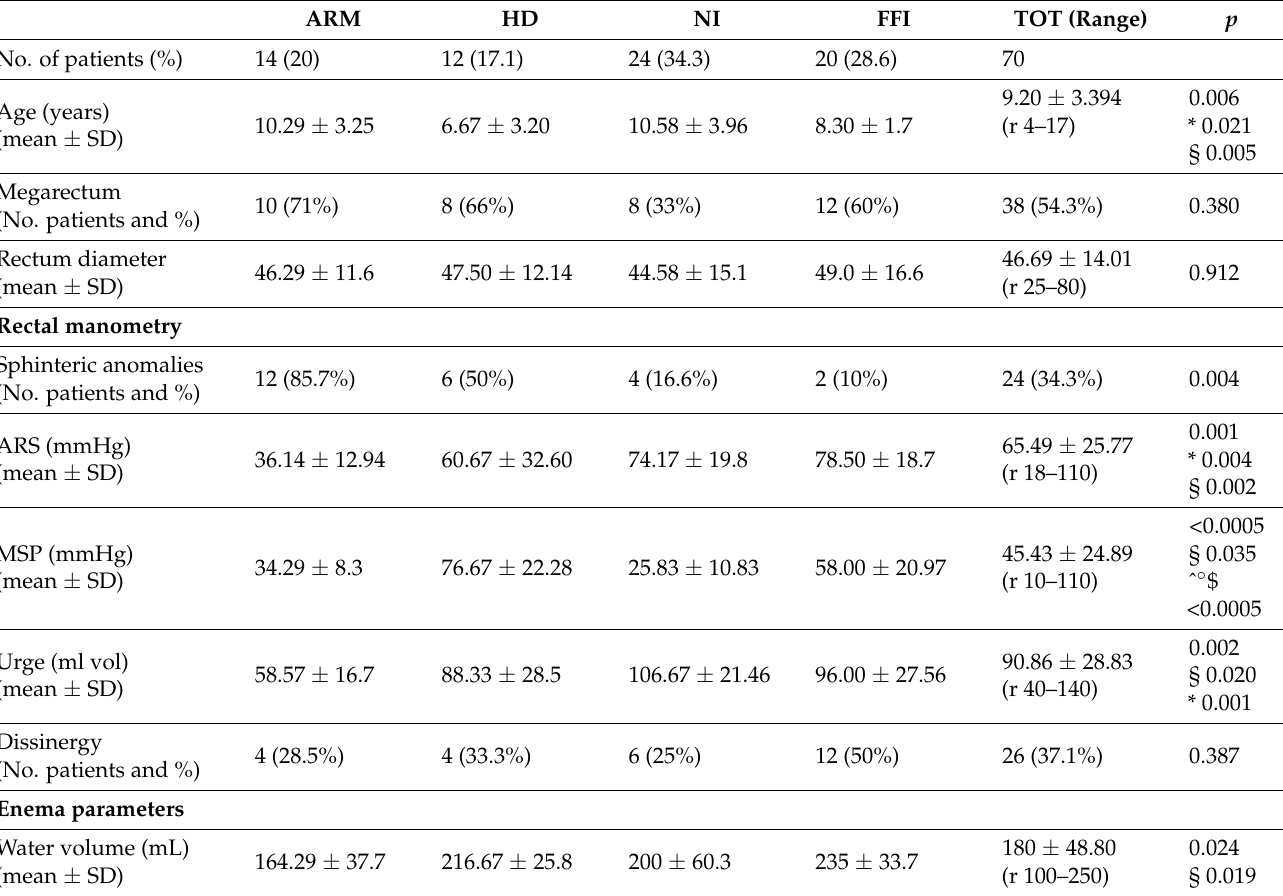
Table 1. Pretreatment parameters in each